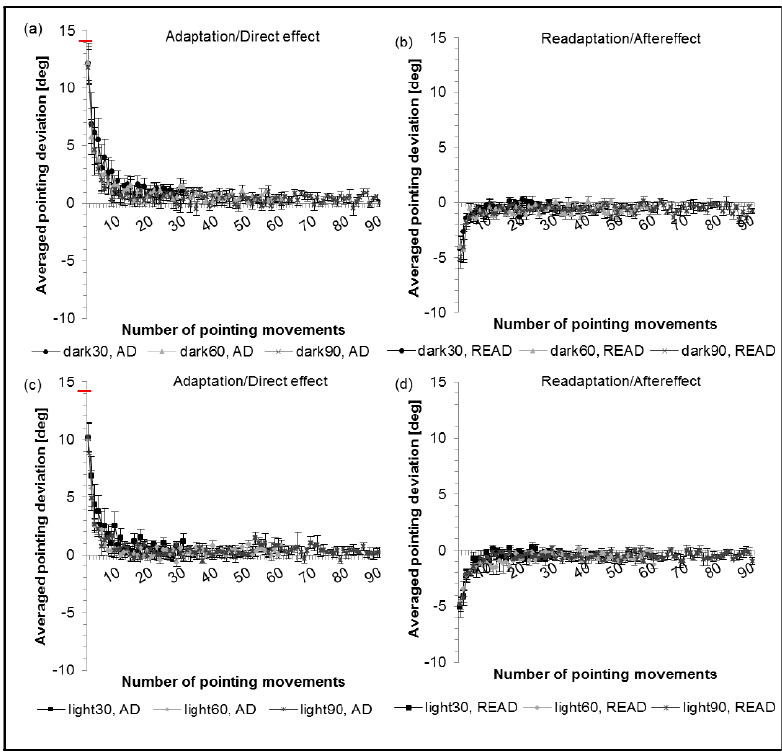
Figure 4. ( a , c ) Prism adaptation and direct effect; ( b , d ) Readaptation and aftereffect. Dots/triangles/crosses show the averaged results for 30/60/90 pointing movements, respectively, in the dark condition and squares/rhombus/stars the averaged results for 30/60/90 pointing movements in the light condition. Error bars denote SEs. Y-axis: horizontal deviation of the averaged pointing movements from the central target (y = 0), the red bar indicates the optical power of the prisms. X-axis: number of pointing movements performed.